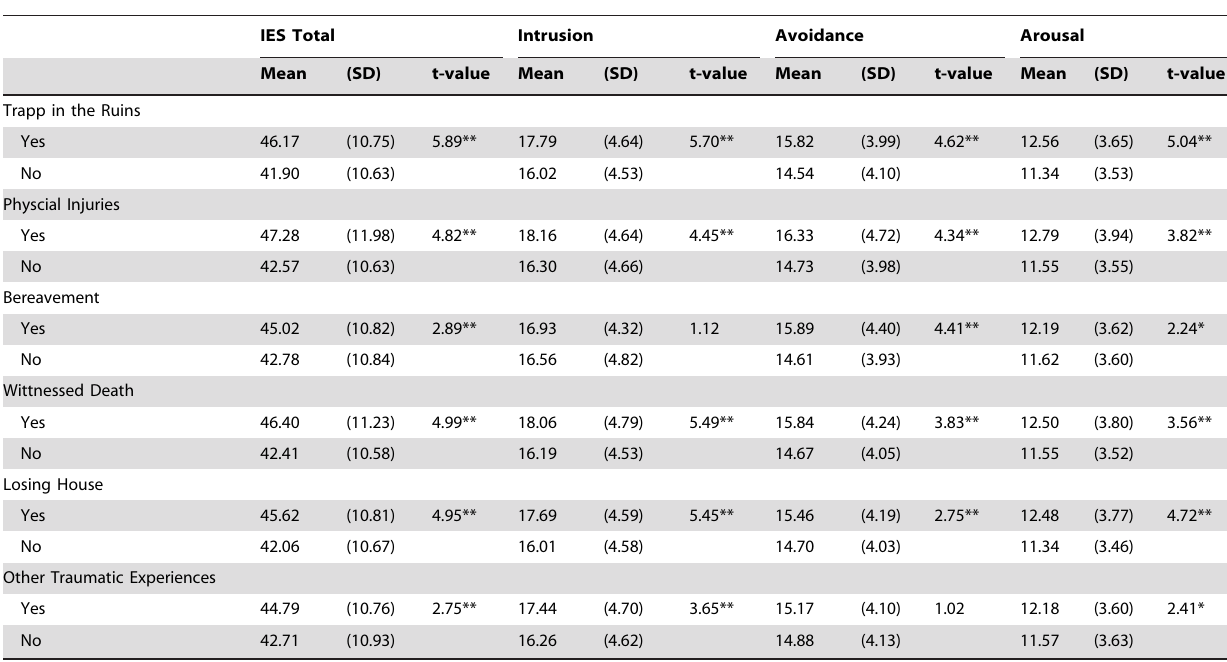
Table 4. Relationship between PTSD symptoms and trauma exposure.